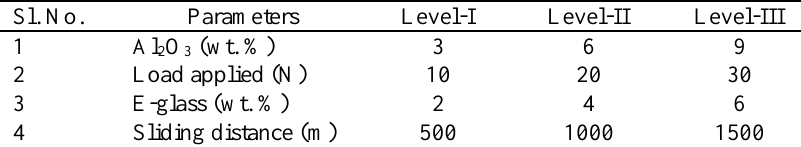
Table 1. Their levels and process parameters Sl.